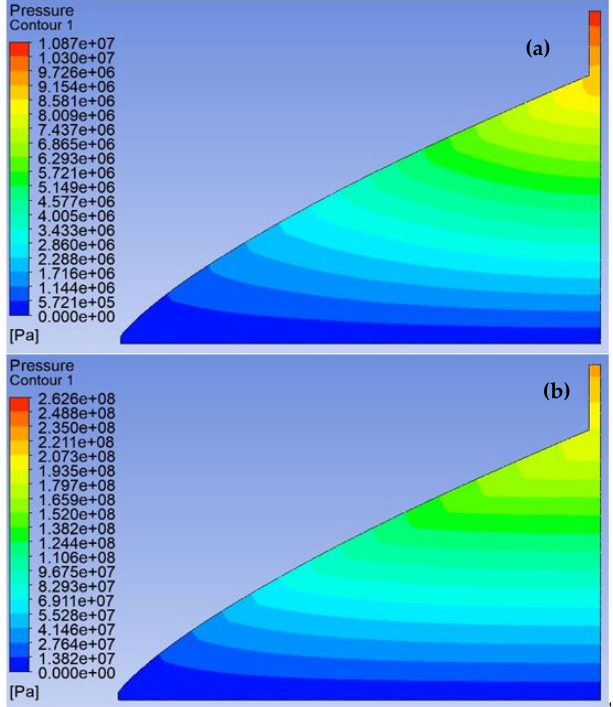
Figure 12. Pressure contour plots of extrusion: ( a ) material #2 and ( b ) material #3.